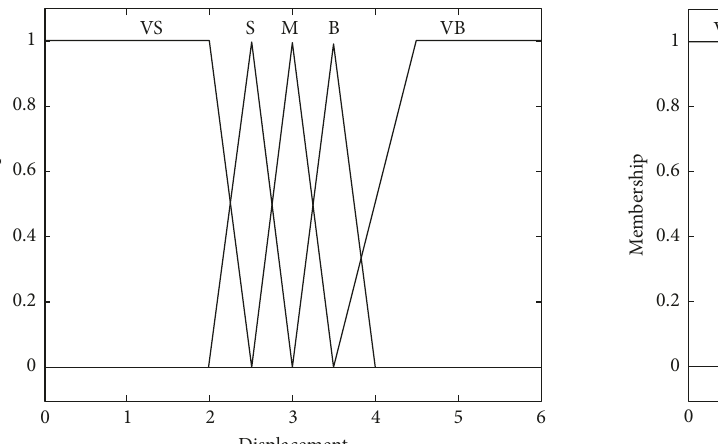
Figure 8: Displacement membership function curve.